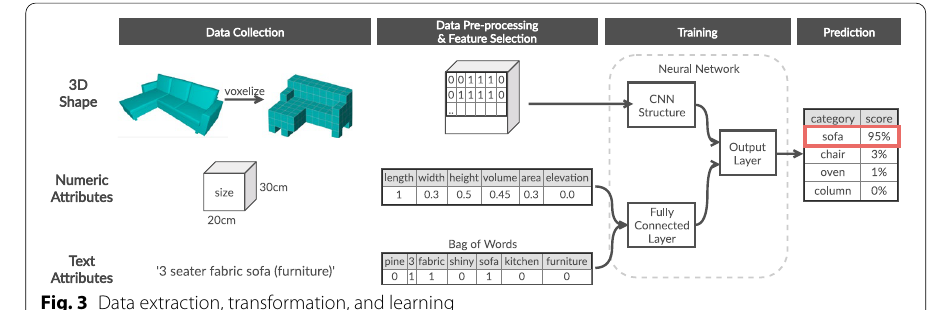
Fig. 3 Data extraction, transformation, and